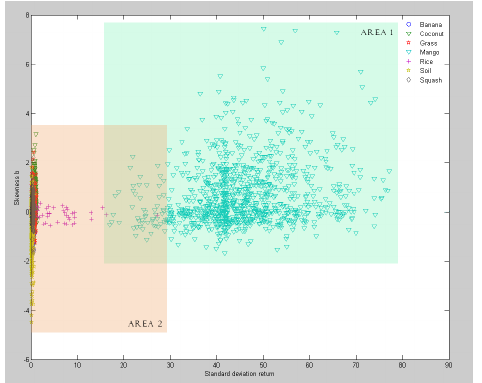
Figure 6. Overlap of bounded are for class mango versus mixed class.